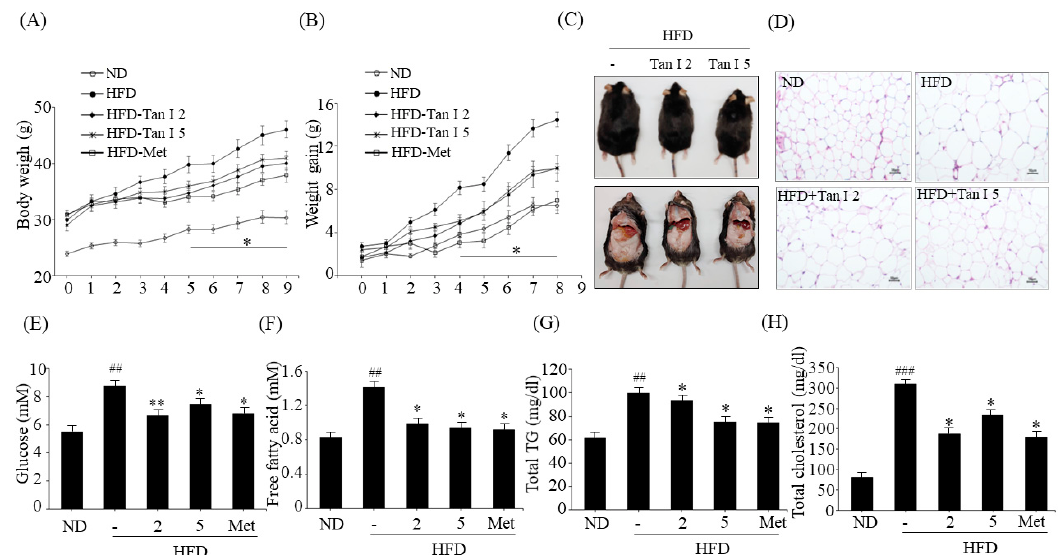
Figure 1. Tanshinone I (Tan I) prevented high-fat-diet (HFD)-induced obesity and ameliorated blood biochemical parameters in mice. ( A ) Body weight. ( B ) Weight gain. ( C ) Photograph of whole body and visceral adipose tissues. ( D ) Hematoxylin and eosin (H&E) staining (scale bar, 500 μ m). Blood levels of glucose ( E ), free fatty acid ( F ), total TG ( G ), and total cholesterol ( H ) in HFD obese mice. The data are presented as the mean ± SEM of ten mice. ## p < 0.01, ### p < 0.001 vs. normal diet (ND)-fed mice, * p < 0.05, ** p < 0.01 vs. HFD-fed mice. Met means metformin administration.